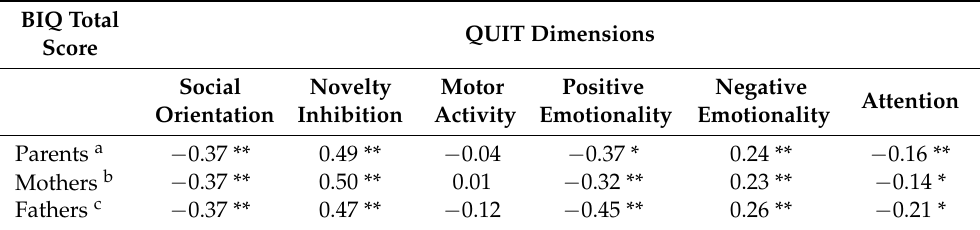
Table 6. Correlations between BIQ total scores and Italian Questionnaires of Temperament (QUIT) scores.